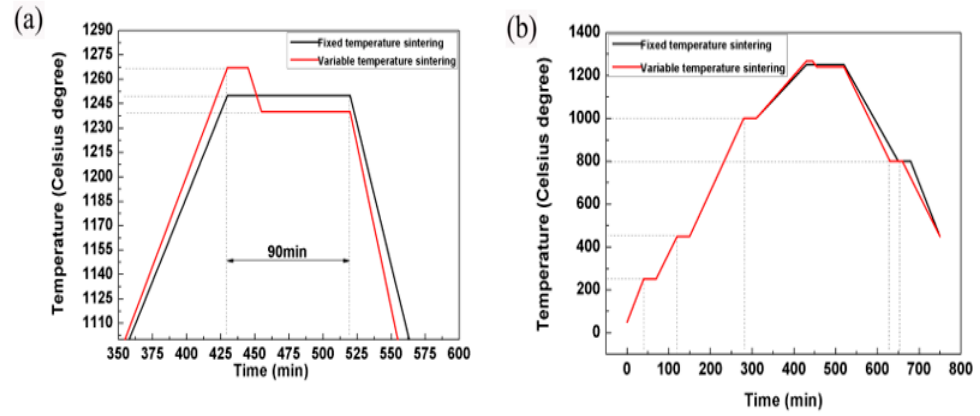
Figure 1. Schematic of the SLPS of two sintered HCCI: ( a ) whole diagram, ( b ) partial enlargement.